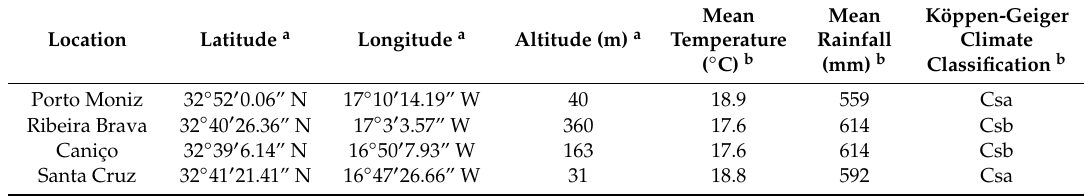
Table 1. Geographic coordinates and climate conditions of the four regions of Madeira Island where the onions were